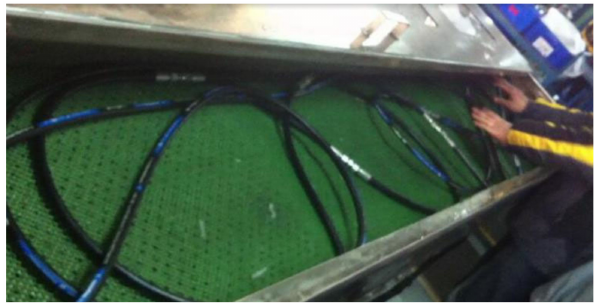
Figure 16. Experimental study on maximum hose capacity. Nine groups of pressure tests were carried out on six hose assemblies, and the pressure is set to 85 MPa each time. The pressure data are recorded every second. The pressure data of the nine groups are shown in Table 8. From the standard deviation of the nine sets of data, we can see that the data measured by the experiment is stable. The pressure curve inside the hose is shown in Figure 17. Table 8. Sheet of Pressure test data (MPa).